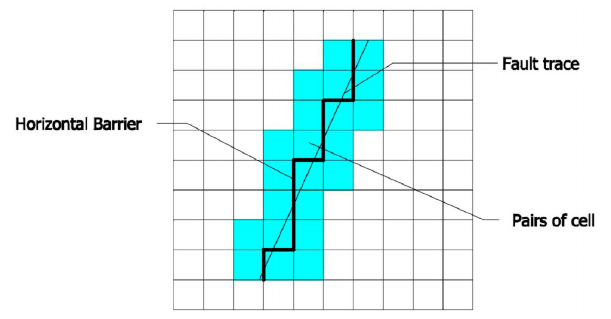
Fig. 2. Representation of fault in the finite difference Figure 2: representation of fault in the finite difference grid